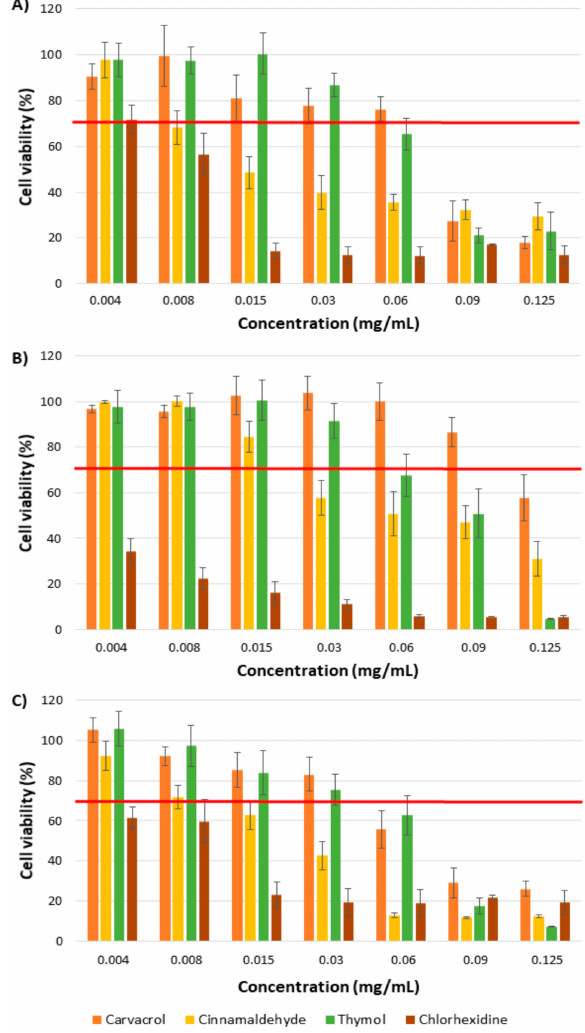
Figure 6. Cell viability after treatment with carvacrol, cinnamaldehyde, thymol and chlorhexidine for 24 h on human dermal fibroblasts ( A ); macrophages ( B ); keratinocytes ( C ). Control sample (untreated cells) = 100%